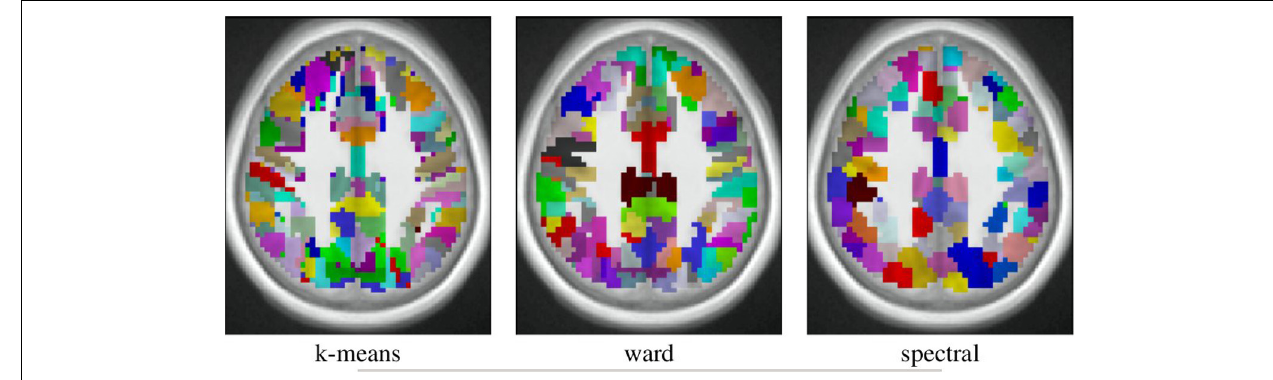
FIGURE 3 | Example of parcellation with 500 parcels on the Localizer dataset.